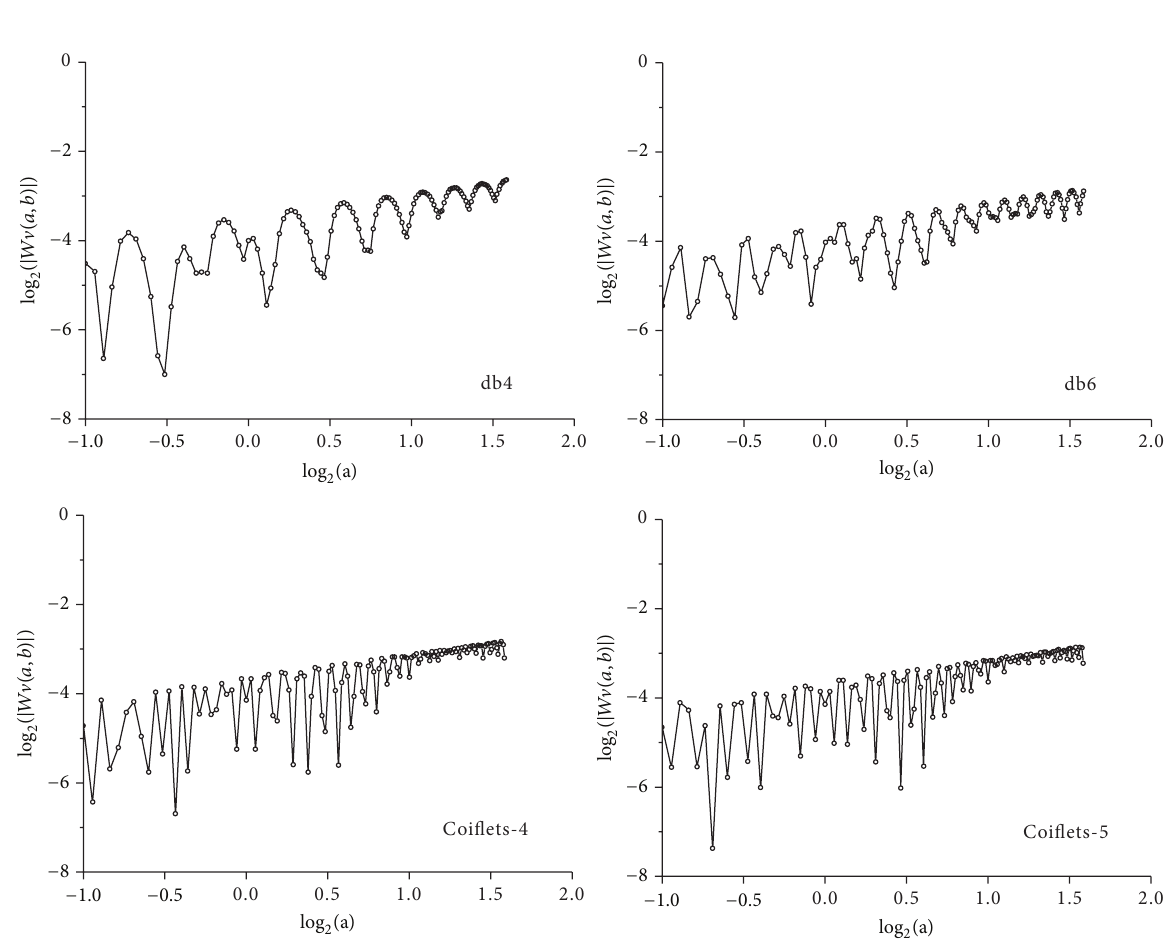
Figure 13: Decay behaviour along the modulus maxima line with different vanishing